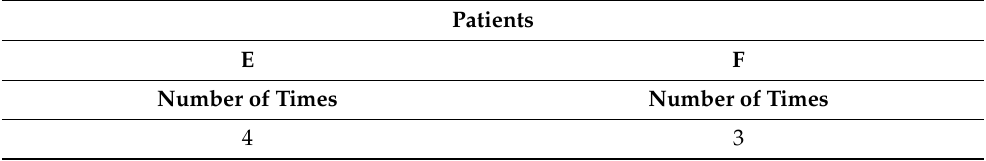
Table 17. Results of eye movements considering time lags in the principal indoor